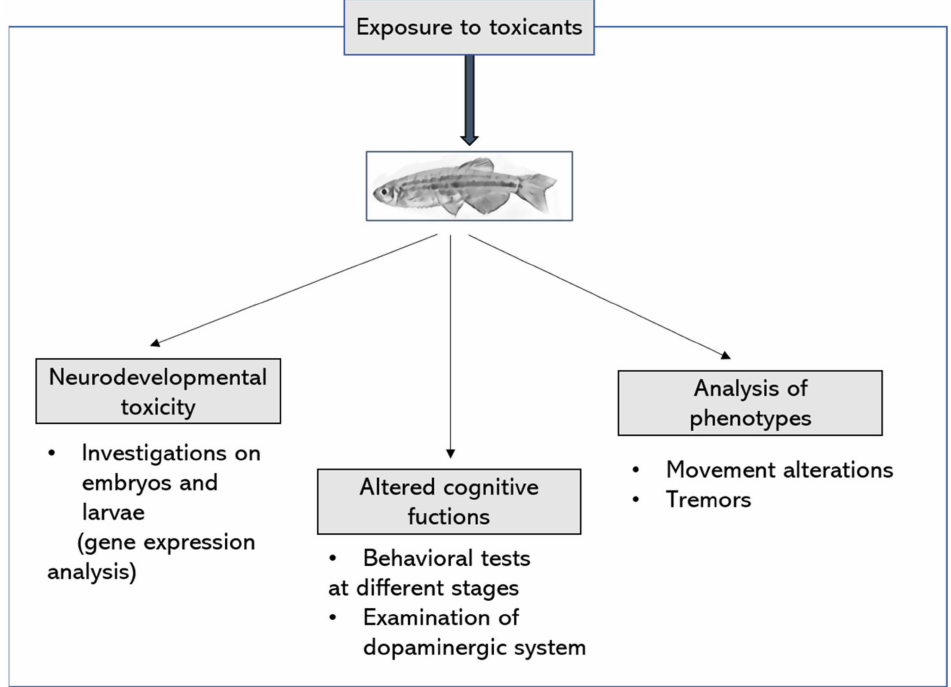
Figure 2. Example of experimental design and principal biological end-points after the exposure of zebrafish to environmental